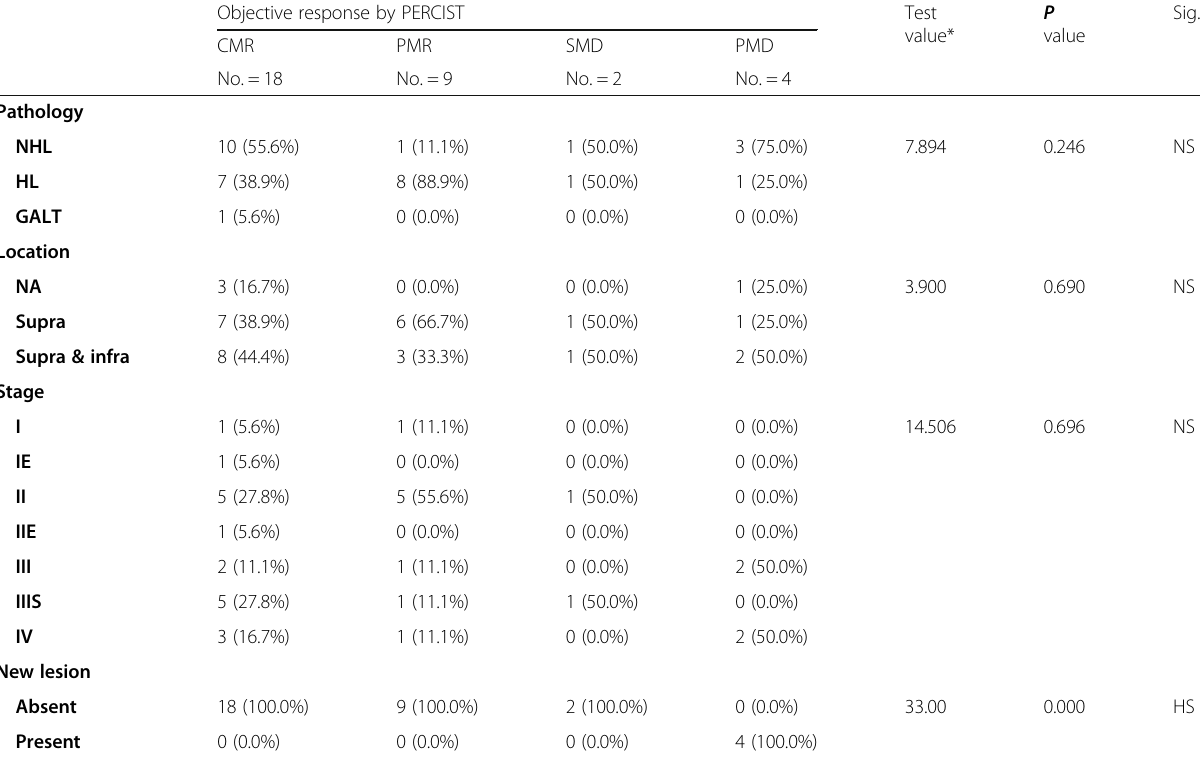
Table 7 Correlation between disease characteristics and PET-based therapeutic response in the study population Objective response by